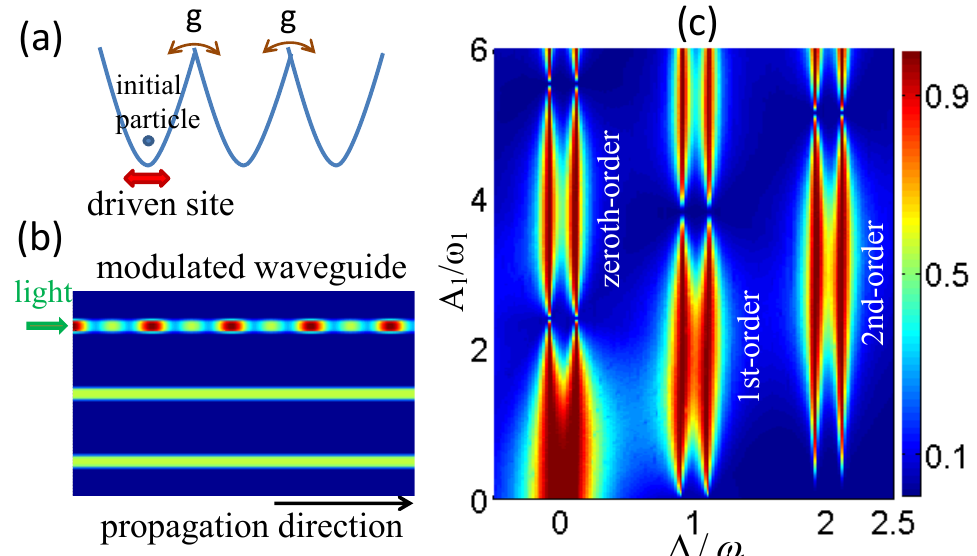
Figure 1. (Color online) ( a ) Schematic diagram for a driven three-well system in which the left-most well (well-1) is driven by a dual-frequency field and the other two wells are undriven. ( b ) Three- coupled waveguides with selective modulation of the top waveguide (waveguide-1) by two harmonic frequencies. ( c ) Tunneling probability Π 1 as a function of ∆ / ω 1 and A 1 / ω 1 . Pairs of bright colors are along the ∆ / ω 1 axis in the vicinity of a series of resonance points ∆ / ω 1 = n where n is an integer. Along the A 1 / ω 1 axis, n -photon-assisted tunneling is almost completely suppressed ( Π 1 ≈ 0) under the conditions of J − n ( A 1 / ω 1 ) = 0. Parameters are varied by changing ∆ and A 1 and fixing ω 1 = 10. The initial conditions are a 1 ( 0 ) = 1, a 2 ( 0 ) = 0, a 3 ( 0 ) =